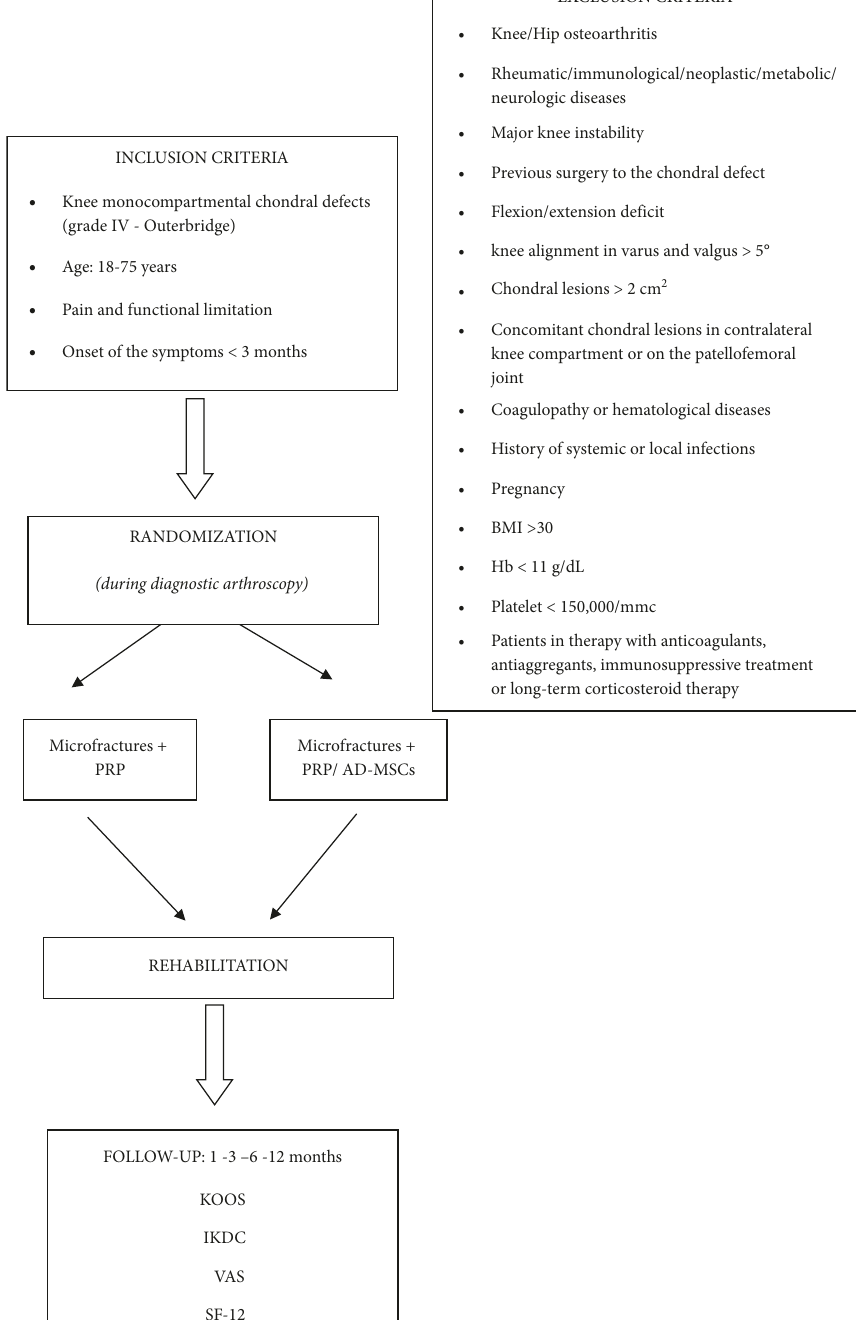
Figure 1: Flow chart: overview of the